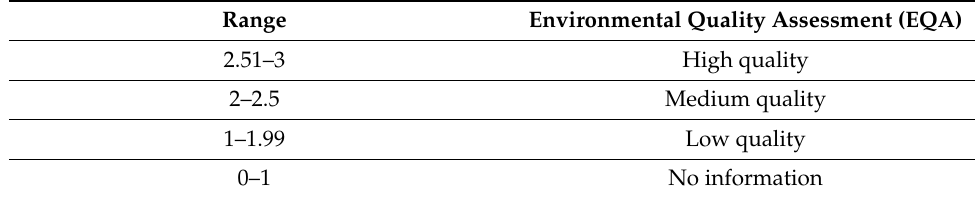
Table 5. Environmental quality assessment grades.